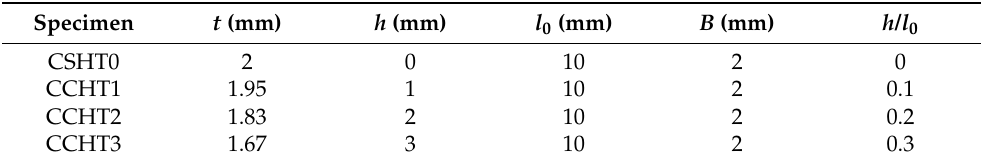
Table 1. The geometric parameters of the